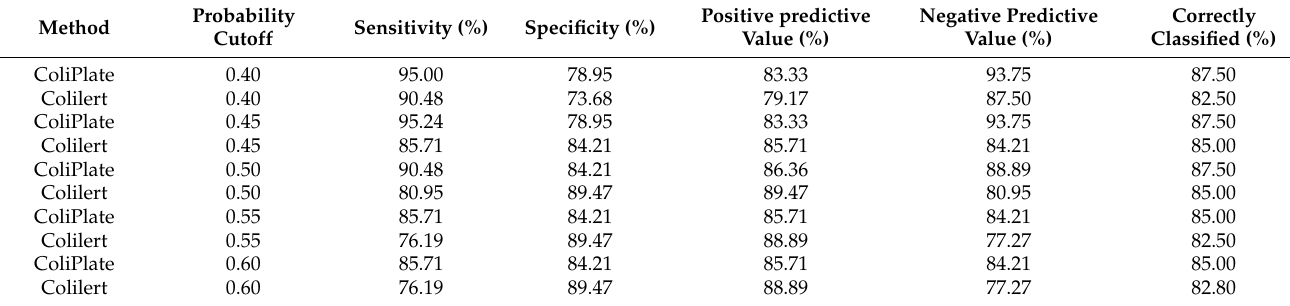
Table 3. Performance of the ColiPlate and Colilert logit models for predicting water quality results exceeding the World Health Organization-determined very high-risk level whereby E. coli density is or exceeds 100 colony-forming units per 100